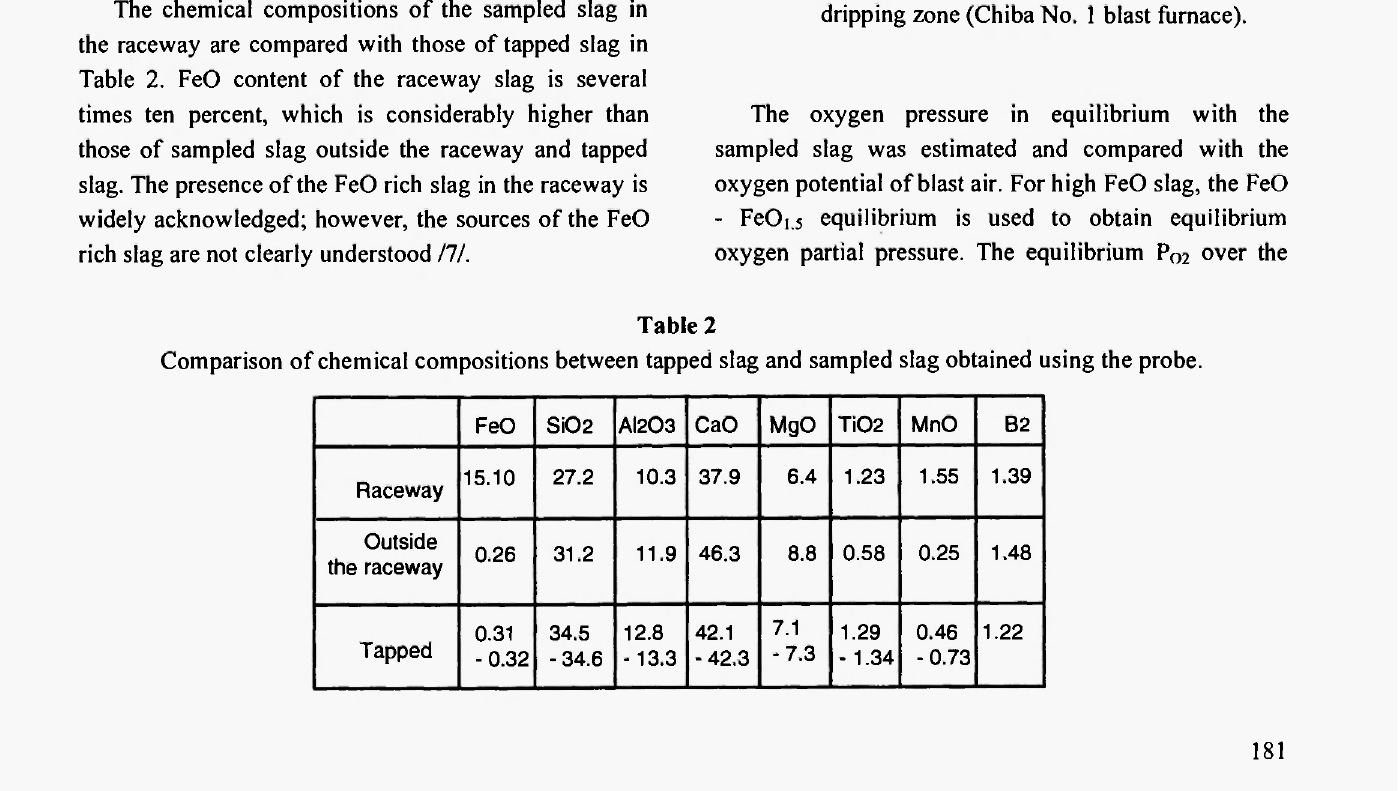
Fig. 9: Change in slag and metal compositions in the dripping zone.